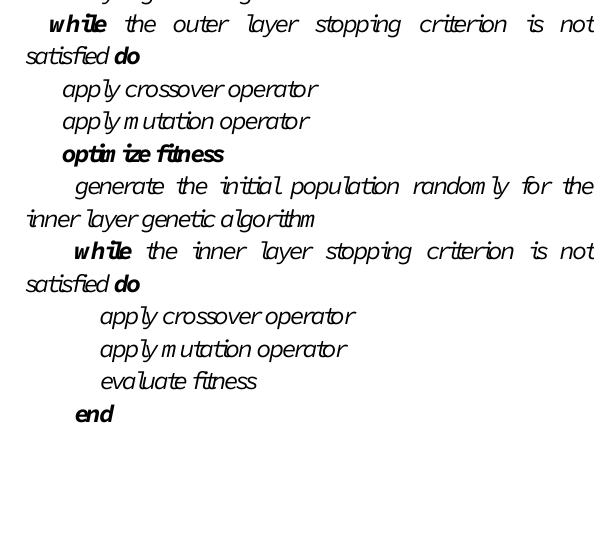
algorithm, 16,17 an improved procedure to solve the hierarchical optimization problem within a single framework, is developed to solve the proposed model. The possible departure times of vehicles at the terminal are searched by the outer genetic algorithm and the skip-stop operations are solved by the inner genetic algorithm. A brief outline of the bilevel genetic algorithm is given below.